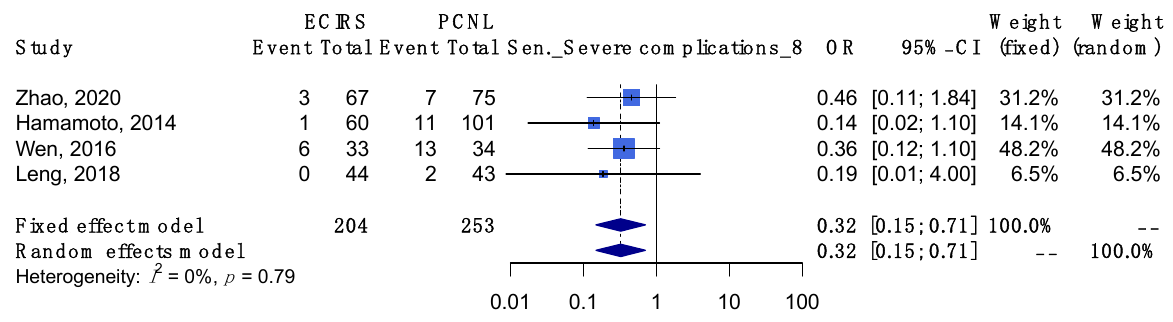
Figure A31. Sensitivity analysis of outcome regarding severe complications. ([17–19,22])